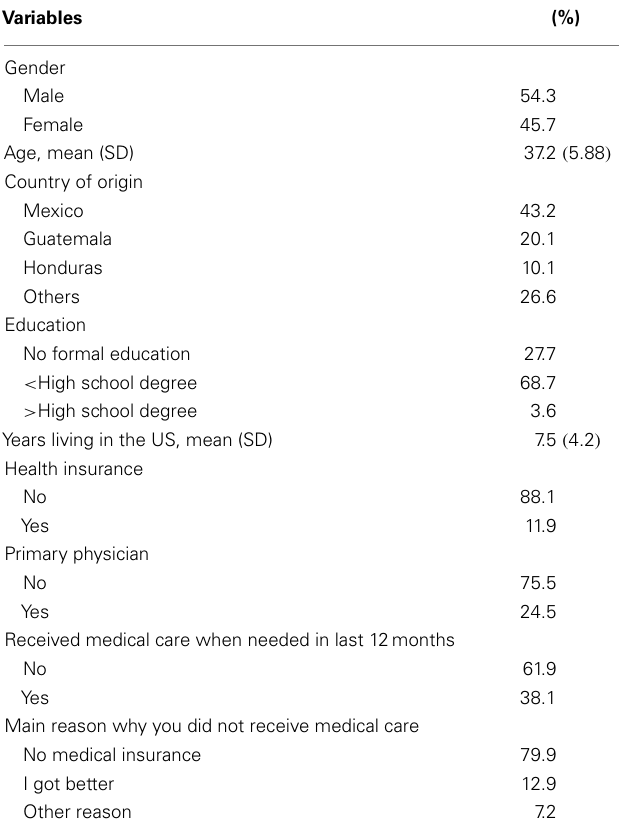
Table 1 | Sociodemographic data among 278 Latino migrant workers .